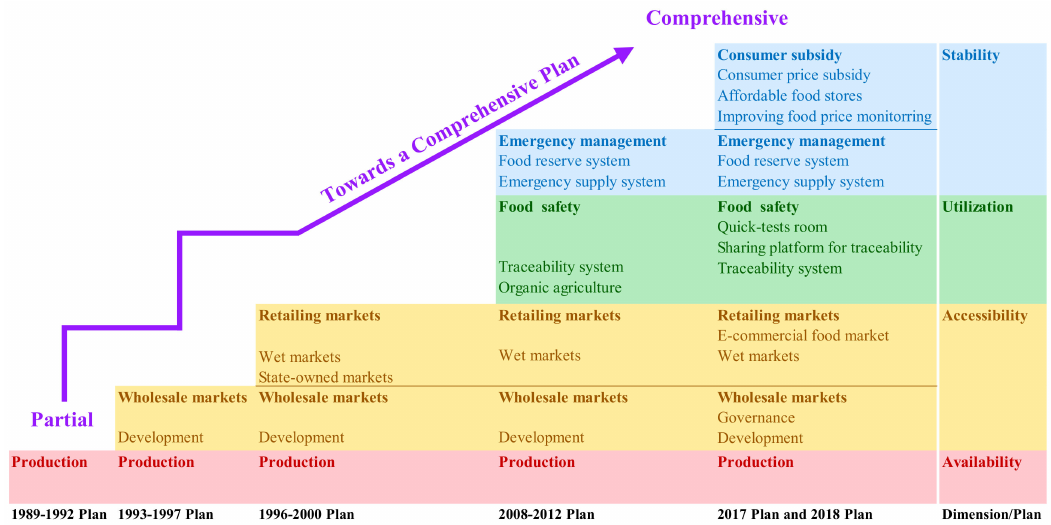
Figure 2. Incremental development of food system planning in Nanjing. (Source: The